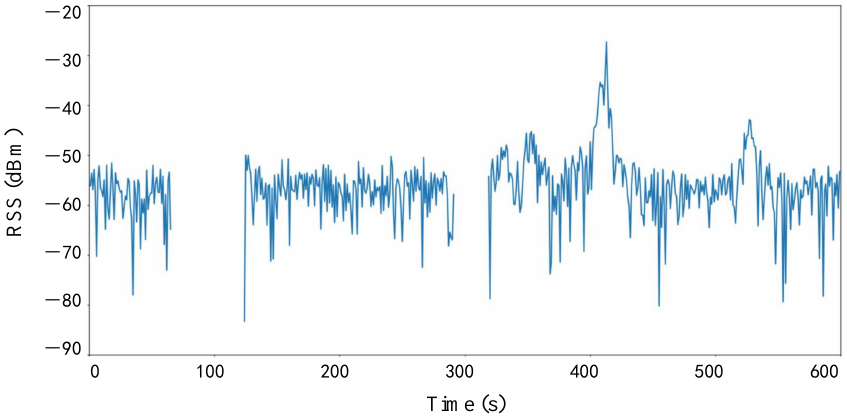
Figure 5. RSS Change